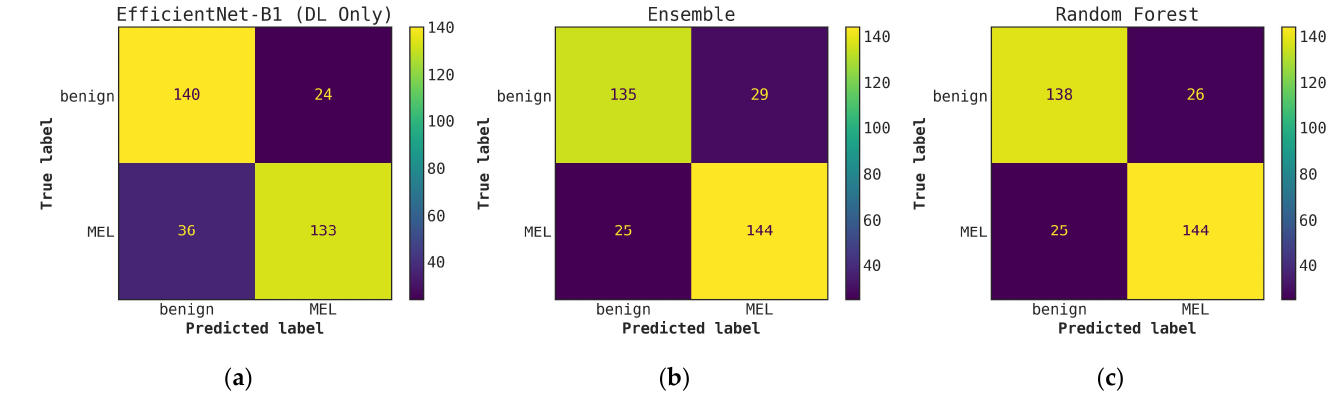
Figure A6. Illustrates a comparison of confusion matrices obtained using cascade generalization, utilizing the probability outputs of the EfficientNet-B1 model. ( a ) Confusion matrix for classification using only the EfficientNet-B1 model (DL-only, level-0); ( b ) Confusion matrix for classification uti- lizing the EfficientNet-B0 probability outputs and hand-crafted features, obtained through an en- semble of conventional classifiers (averaging); ( c ) Confusion matrix for classification using Efficient- Net-B1 (level-0) probability outputs and hand-crafted features for the best conventional classifier, random forest. All confusion matrices are generated after applying a threshold of 0.5 to the model’s probability outputs to obtain the final predictions.